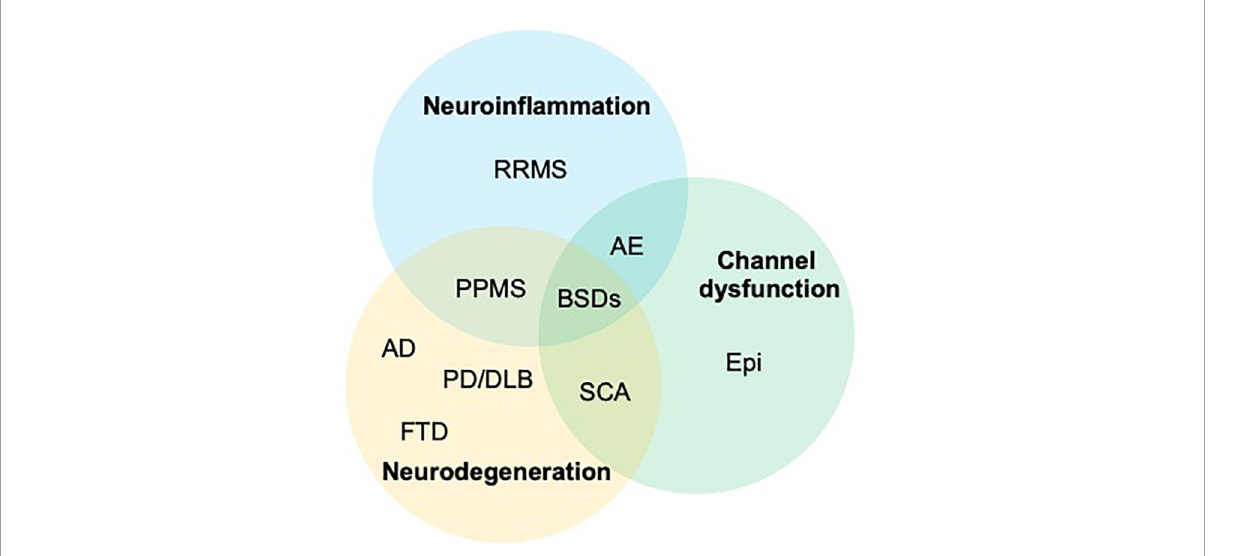
FIGURE3 The graph outlines the intersections of three main pathological changes affecting the central nervous system and shows how all three are involved in the onset of bipolar spectrum disorders (BSDs). AD, Alzheimer’s disease; AE, autoimmune encephalitis; bvFTD, behavioral variant of frontotemporal dementia; Epi, epilepsy; PD/DLB, Parkinson’s disease, dementia with Lewy bodies; PPMS, primary progressive MS; RRMS, relapsing remitting multiple sclerosis; SCA, spinocerebellar